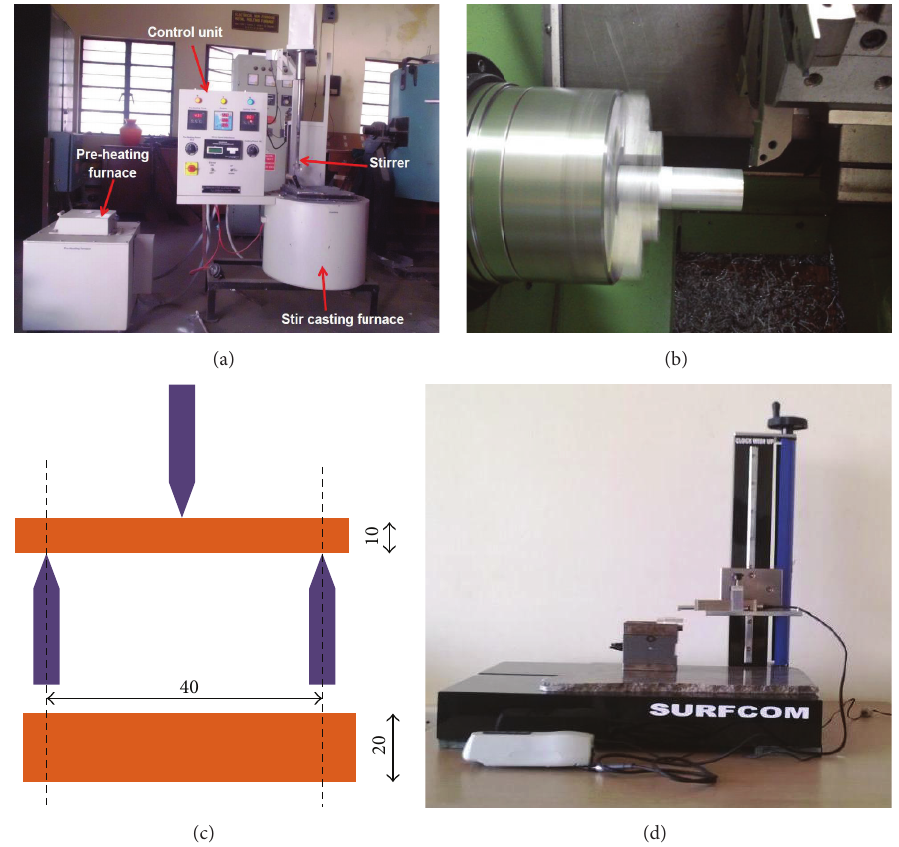
Figure 1: (a) Stir casting set-up. (b) Smart Jr CNC Turning centre. (c) Schematic of three-point bending test. (d) Handysurf surface roughness measuring